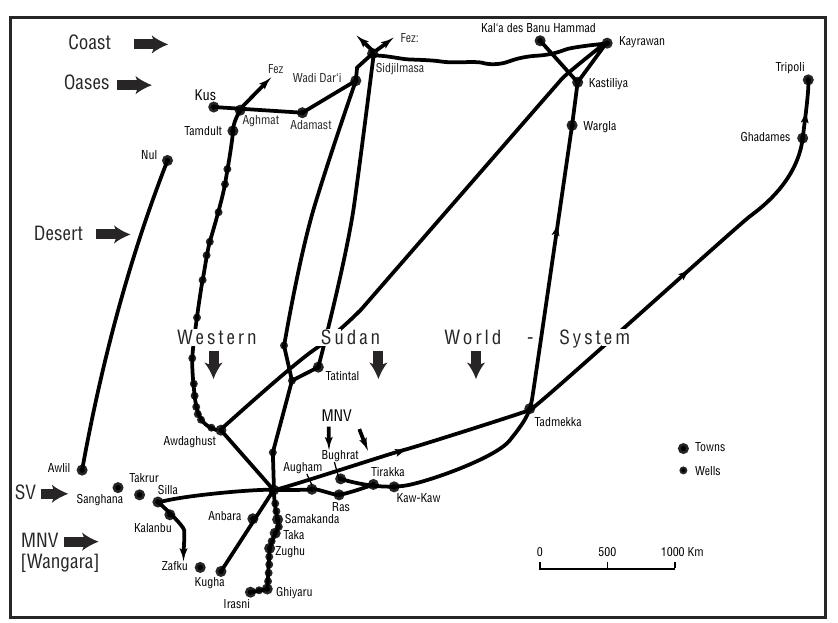
Figure 12 – Western Sudan interaction networks (western part) according to al-Bakri's description (11t c.